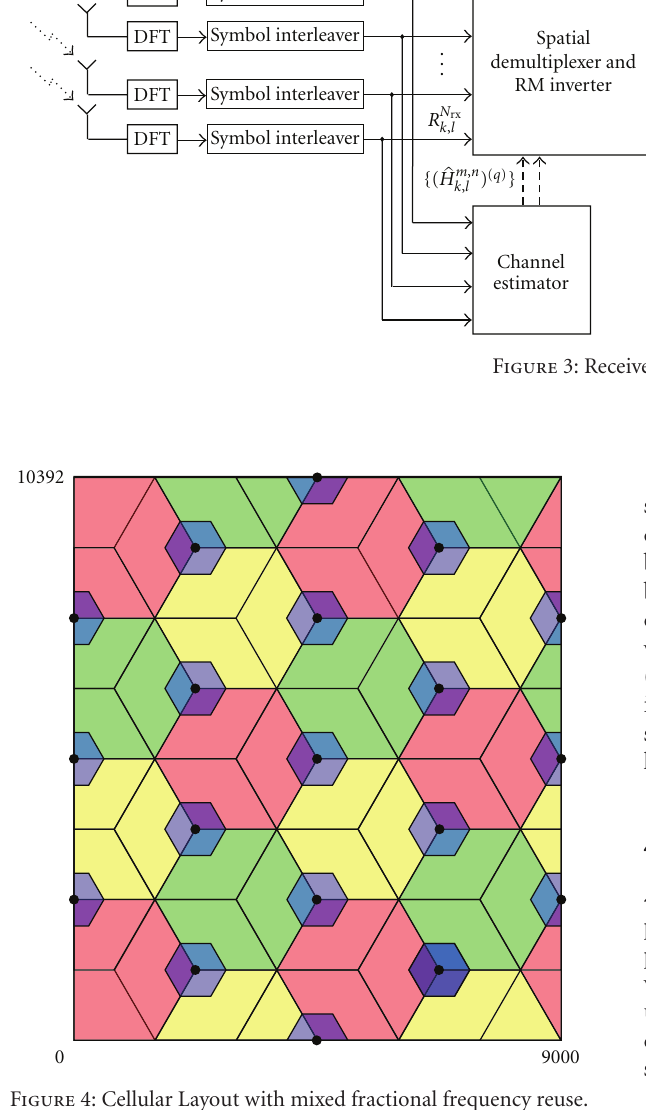
is reduced because only the other base station sites with the same colour remain unsynchronous and capable to